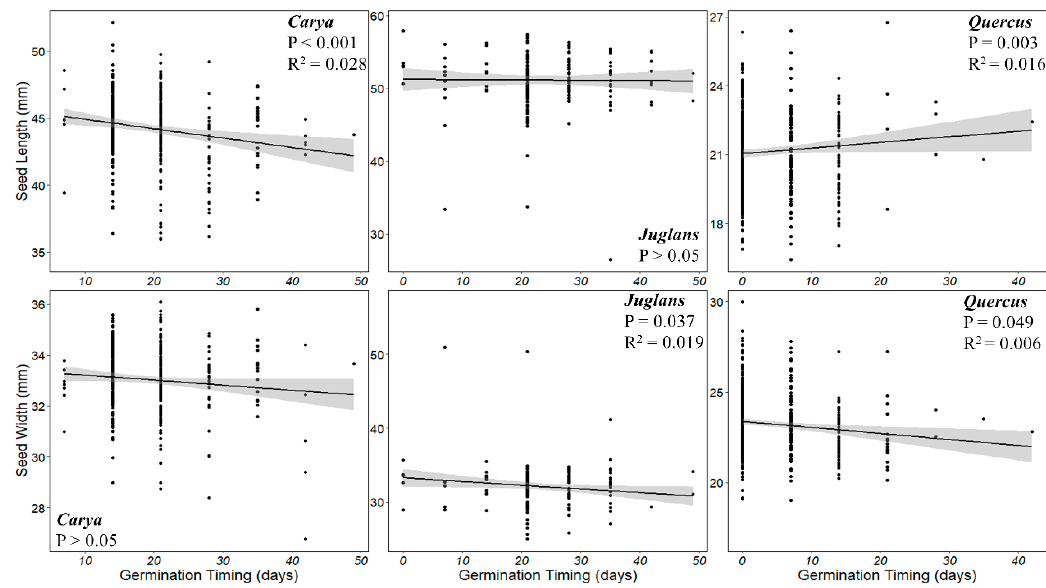
Figure 5. The effect of seed size (length and width of seeds in millimeters) on germination timing of seeds from Carya laciniosa , Juglans cinerea , and Quercus rubra . P -values and R 2 values from linear regressions.